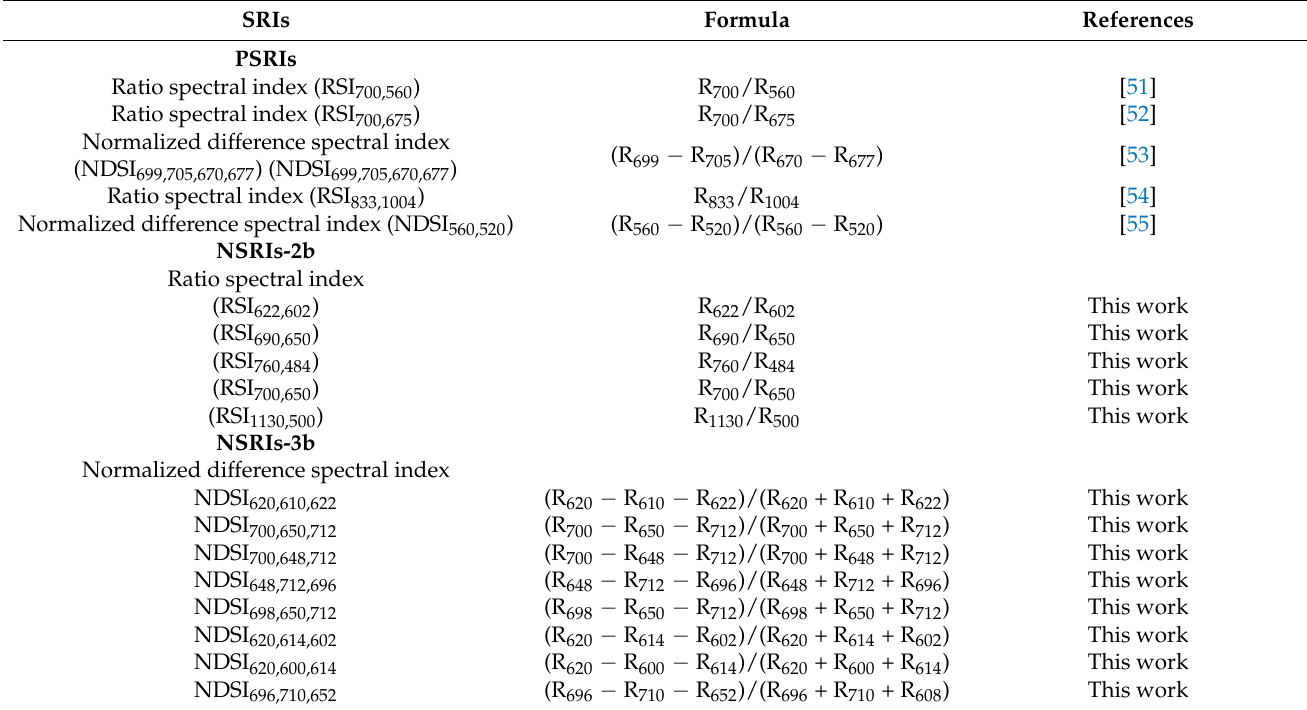
Table 1. Description of the previously published and newly constructed spectral indices tested in this work. SRIs